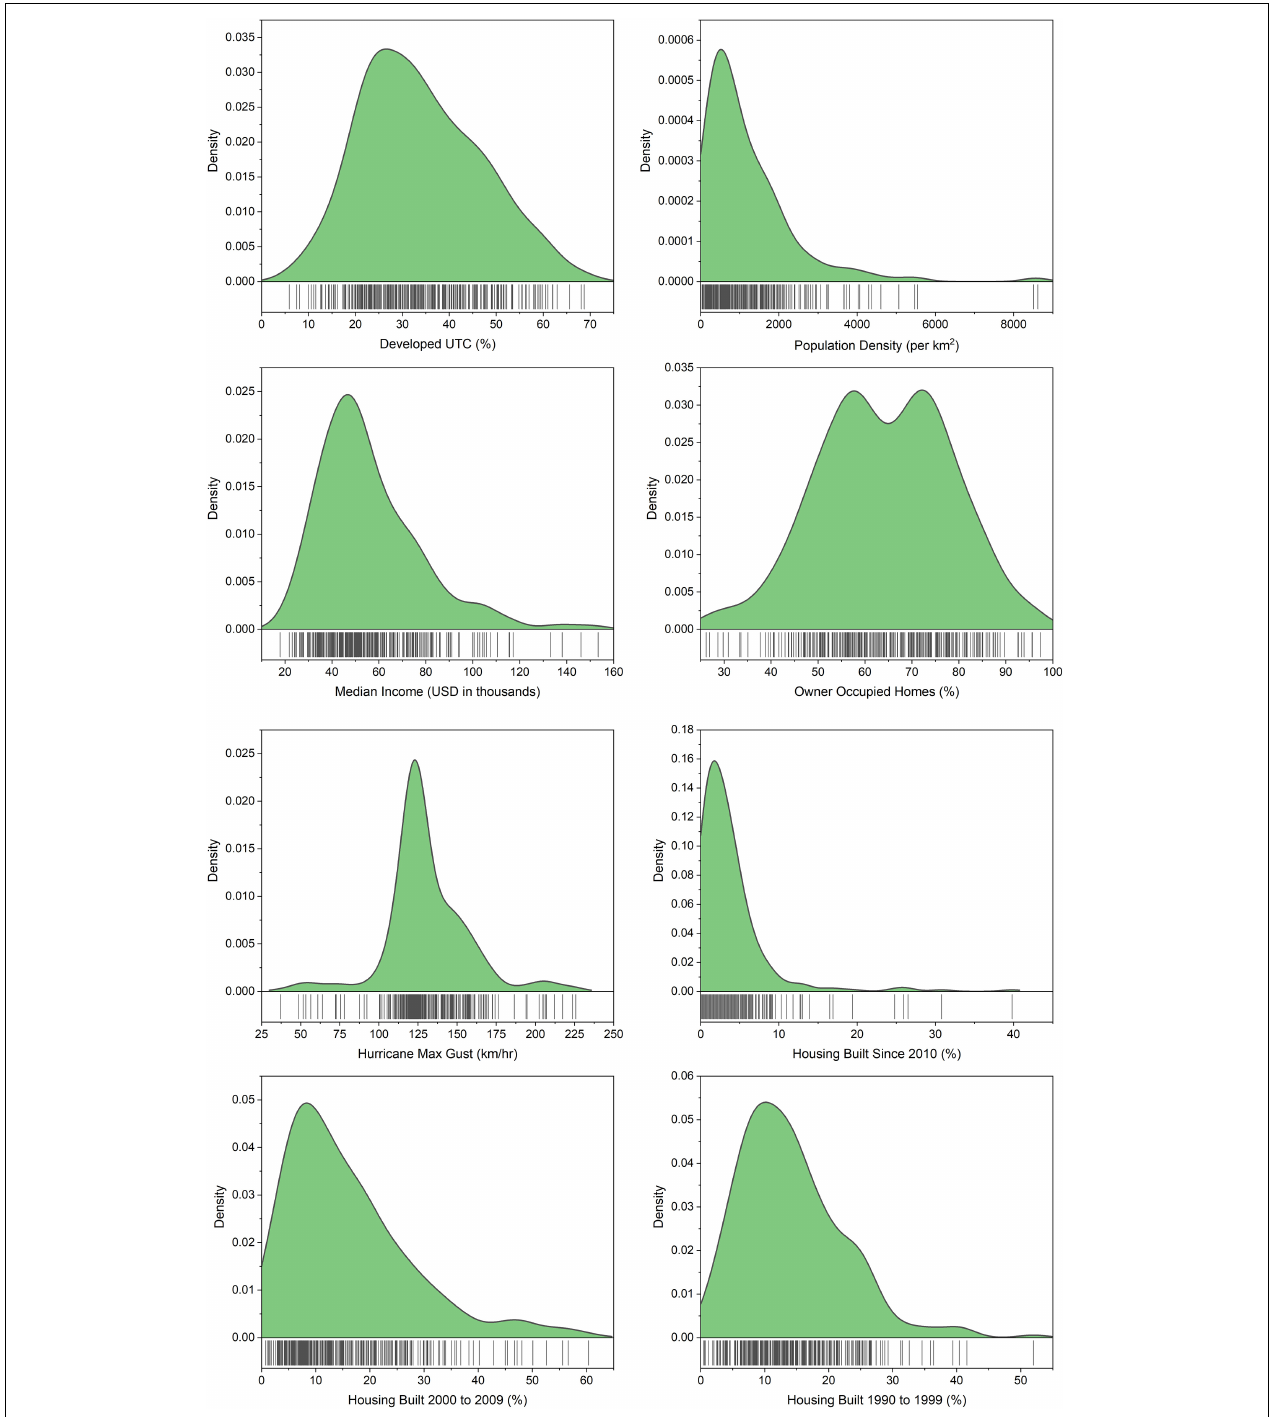
FIGURE 3 | Distributions for the continuous variables used to model canopy coverage in the 300 largest municipalities in Florida, United States. Includes the response variable, developed urban tree canopy [developed urban tree canopy